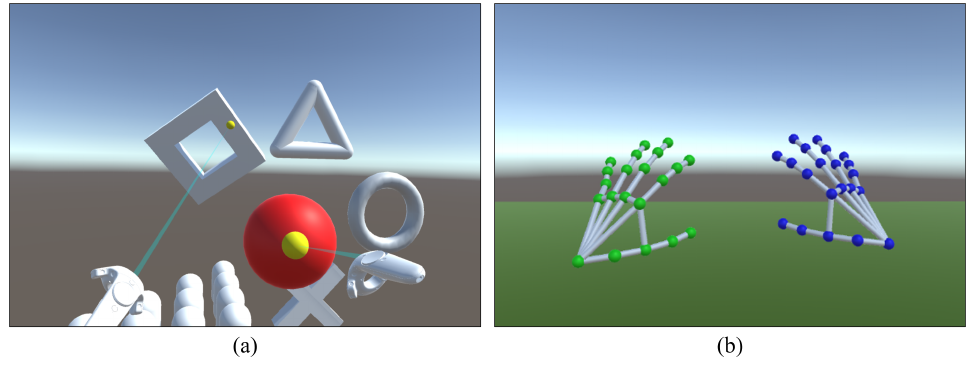
Figure 1. User interface in VR: ( a ) controller; ( b ) hand-tracking